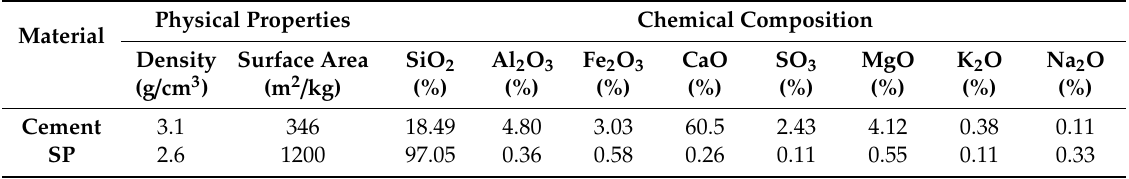
Figure 2. The particle size distribution curve of recycled fine aggregate. Table 1. Physical properties and chemical composition of Portland cement and SP.